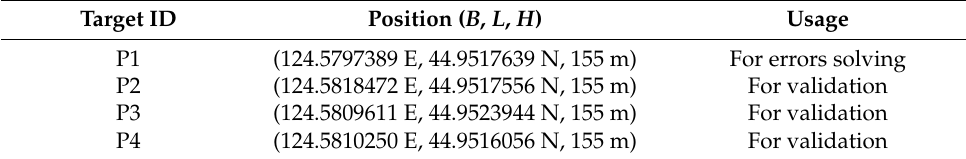
Table 3. Position of target points.